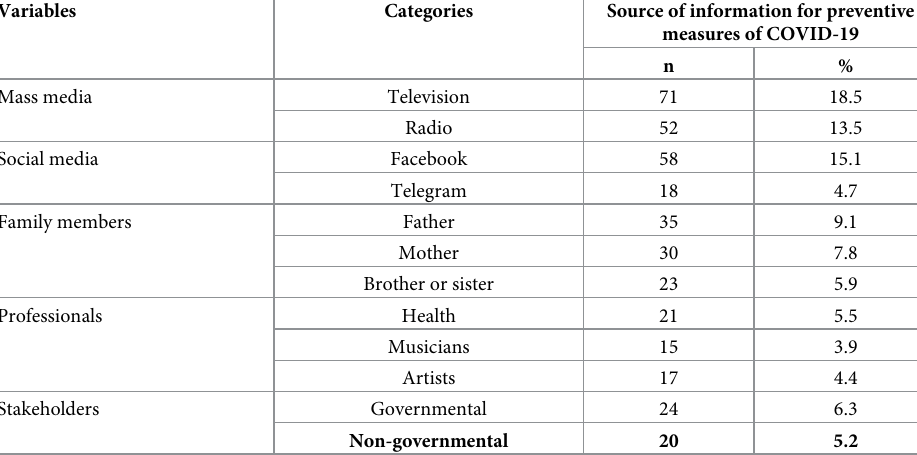
Table 2. Source of information for preventive measures, OSZSF, 2020 (n =